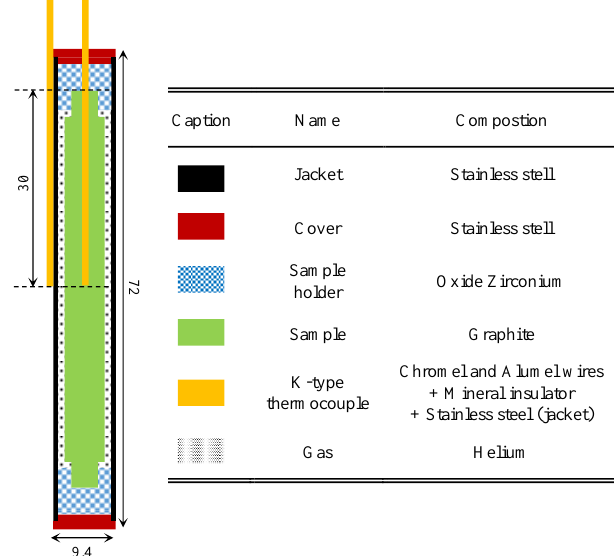
Fig. 2 Scheme of KAROLINA single-cell calorimeter (dimensions expressed in